Question: What kind of plot is shown here?
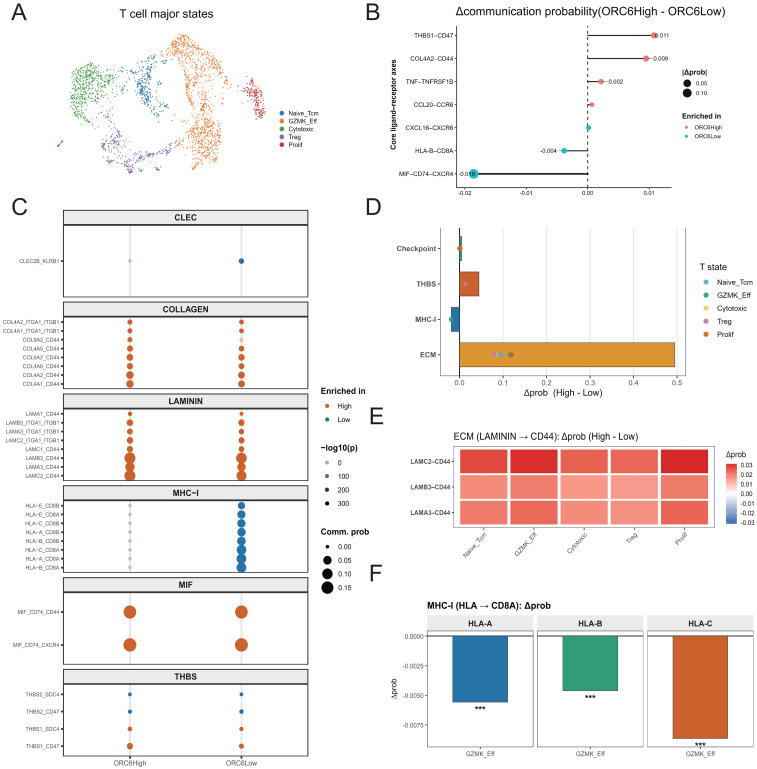
Answer: heatmap